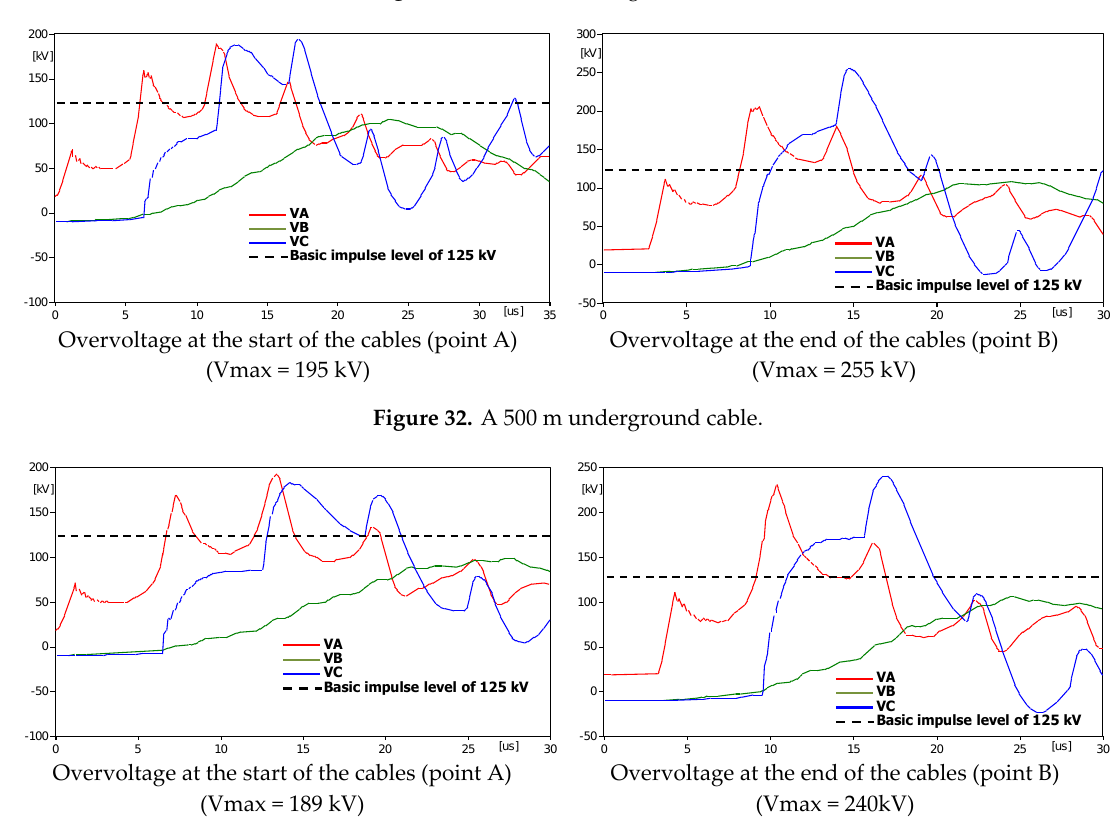
Figure 33. A 600 m underground cable.